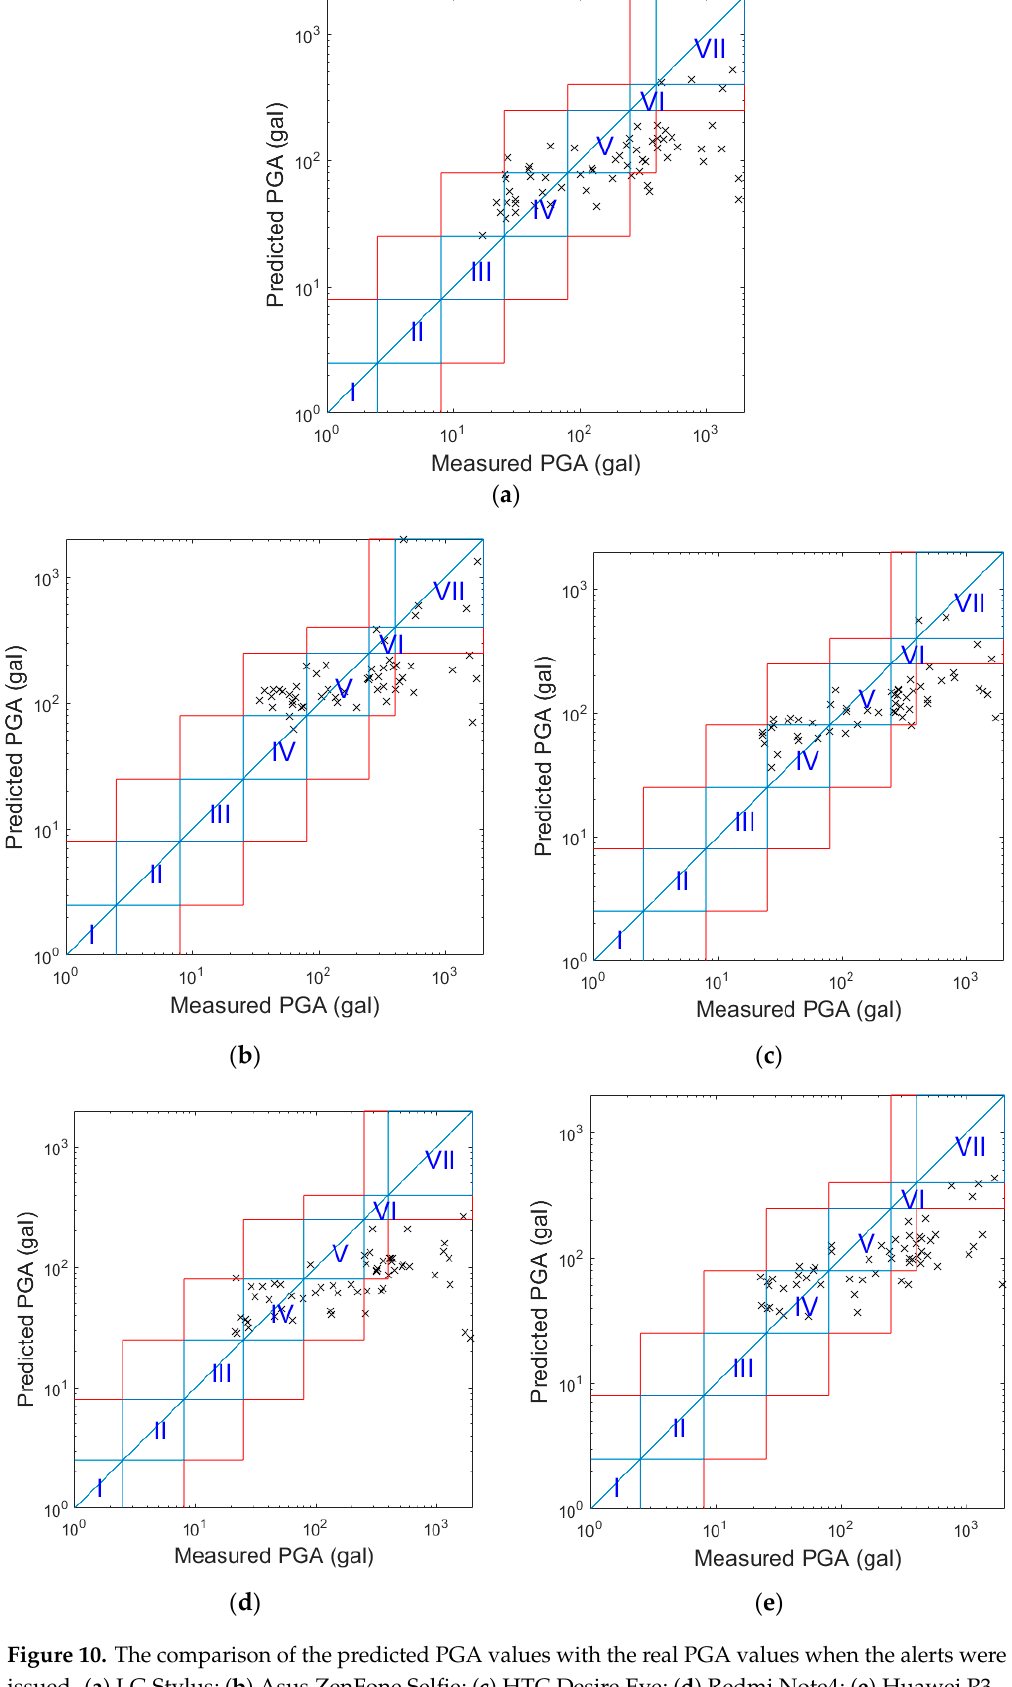
Figure 10. The comparison of the predicted PGA values with the real PGA values when the alerts were issued. ( a ) LG Stylus; ( b ) Asus ZenFone Selfie; ( c ) HTC Desire Eye; ( d ) Redmi Note4; ( e ) Huawei P3.